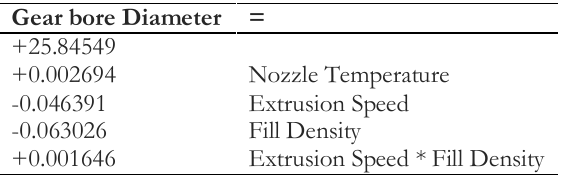
Table 5. Final equation in terms of actual factors.